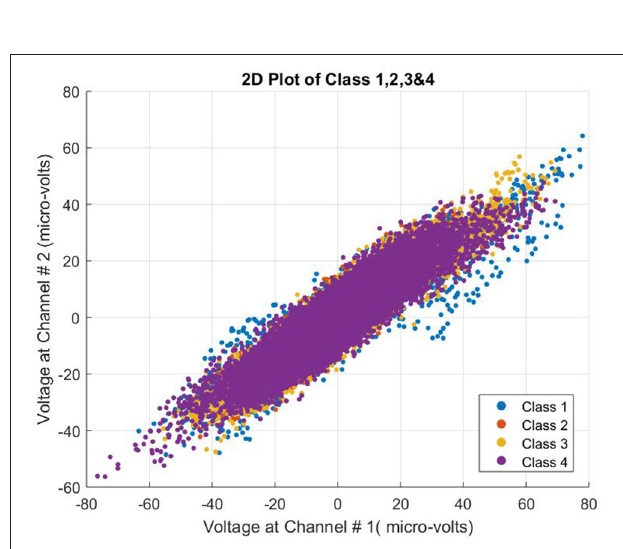
FIGURE 3 | 2D plot of all four classes of subject